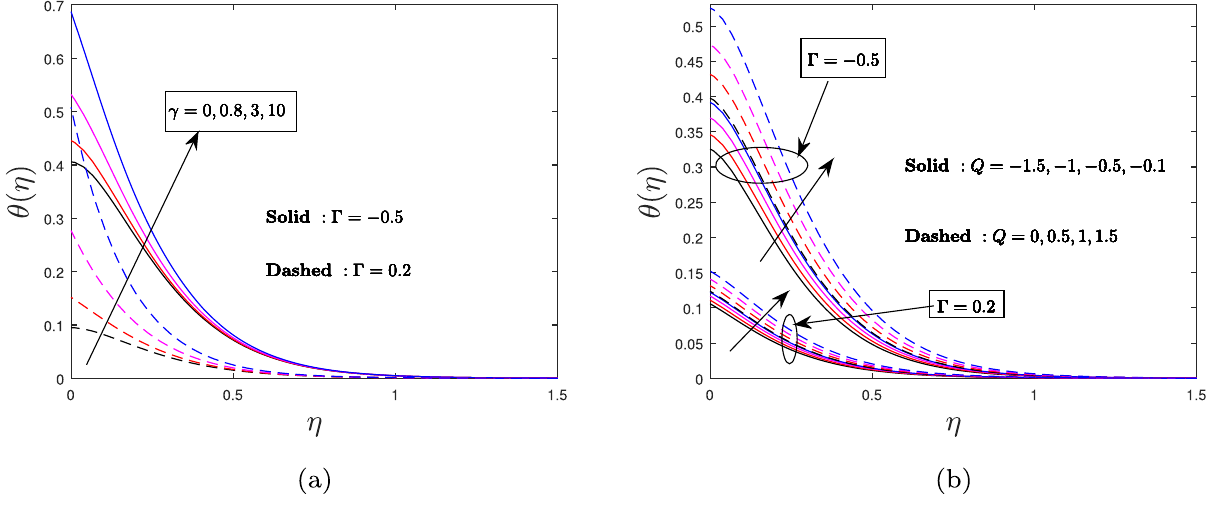
Figure 12: Thermal fi elds against di ff erent ( a ) γ and ( b ) Q .